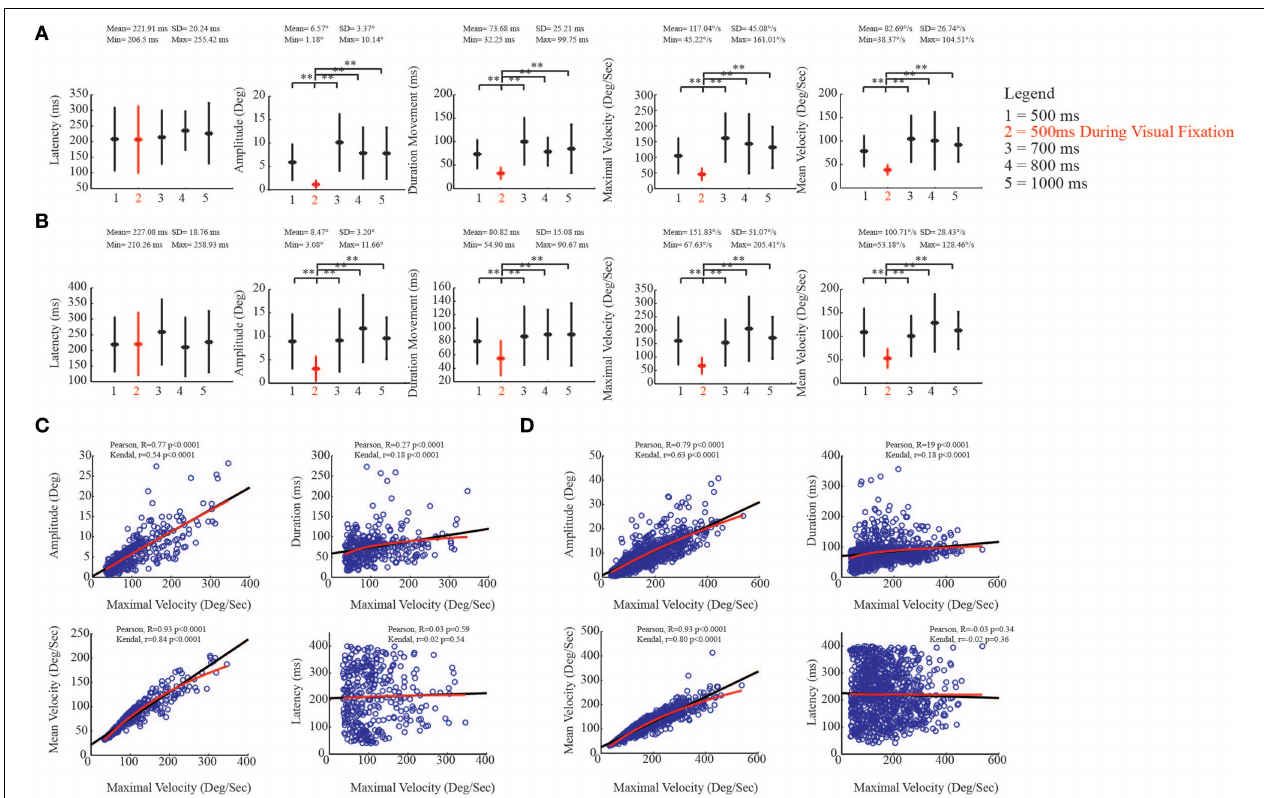
FIGURE 9 | Kinematic study of the evoked eye movements. (A) Plots put in relation eye kinematic parameters of the core region with the duration of stimulation (numbers on x-axis), during visual fixation task (red), and spontaneous conditions (black). The descriptive statistic shows data which are means ± SEM of 353 determinations; ∗∗ p < 0 . 05. Min corresponds to the average minimum value within the 5 conditions. Max corresponds to the average maximum value within the 5 conditions. (B) Plots put in relation eye kinematic parameters of the belt region with the